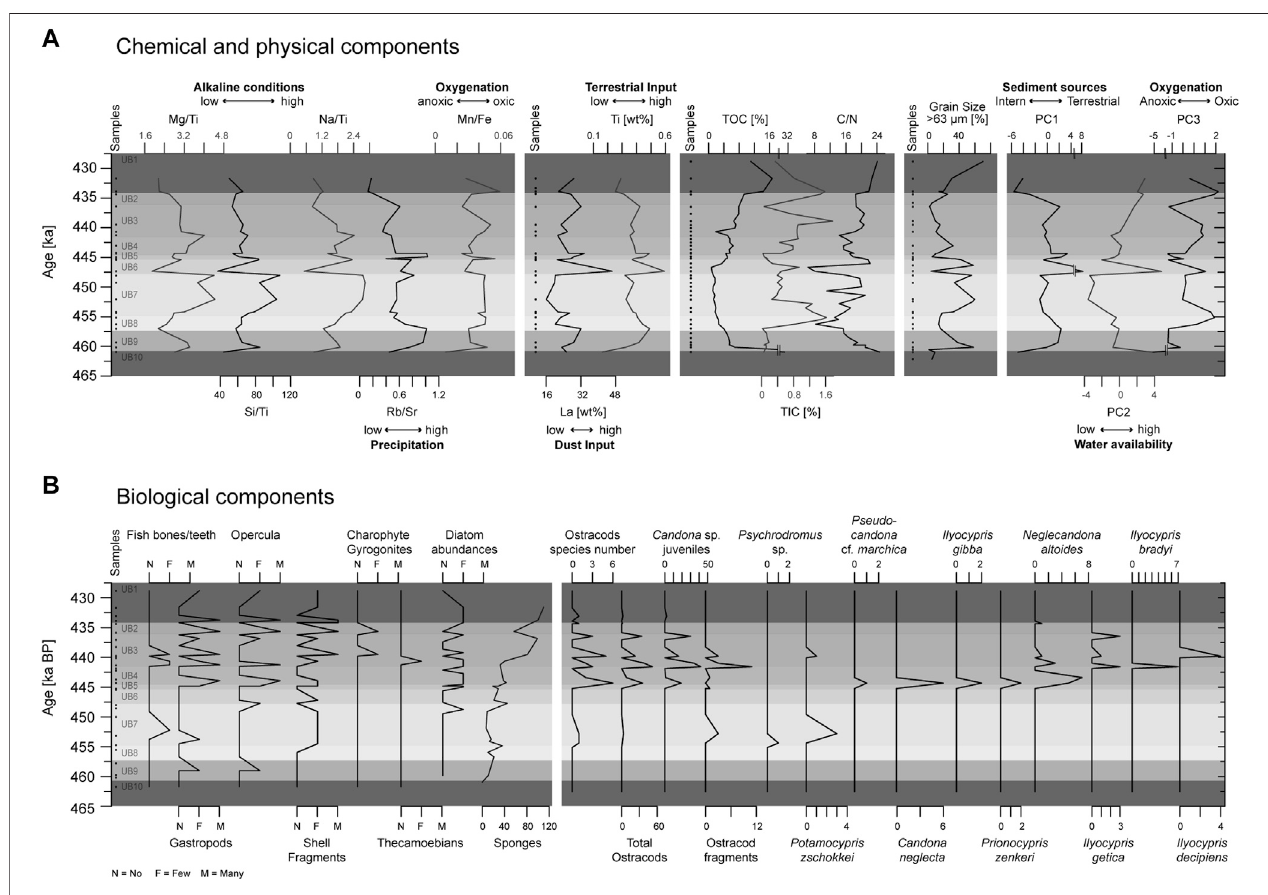
FIGURE5| MultiproxydatafromMAR-1AreaBsedimentsagainsttime.Thedataaredividedintothecategories (A) chemicaland physicalcomponents,including the results of the PCA analysis, and (B) biological components.